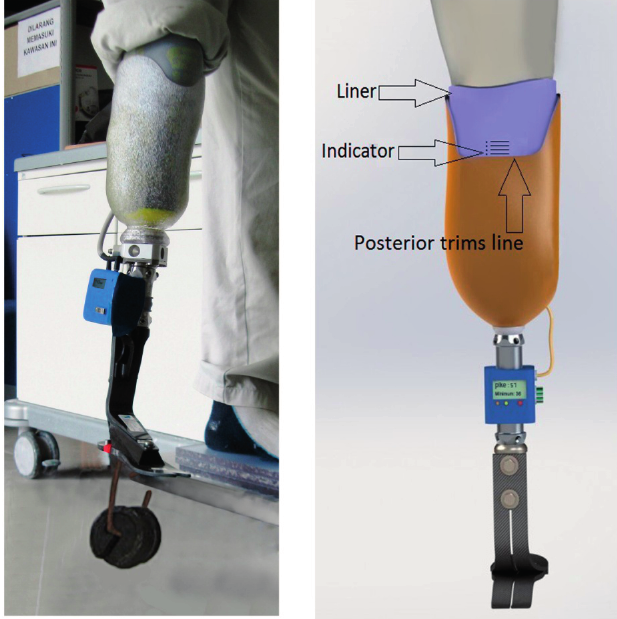
Figure 3. Pistoning within the socket was monitored to measure the vertical displacement